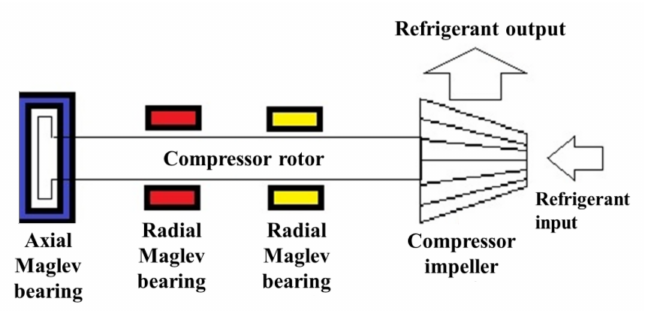
Figure 3. Schematic diagram of the Maglev variable-frequency centrifugal compressor.